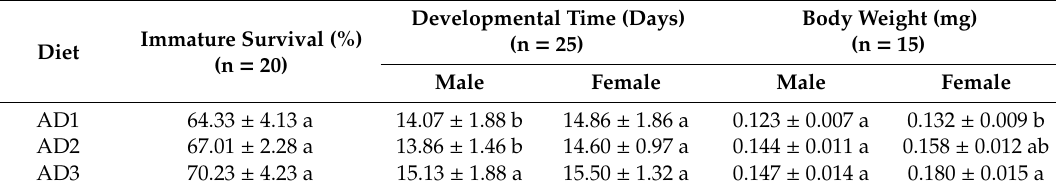
Table 2. Mean ± SE immature survival, developmental time, and adult body weight of S. gilvifrons fed on three di ff erent artificial diets.